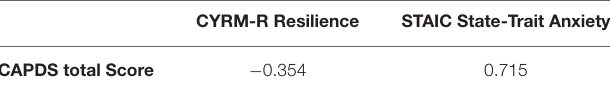
TABLE 4 | Correlation coefficients between the CAPDS-10 tool and the resilience and trait-anxiety